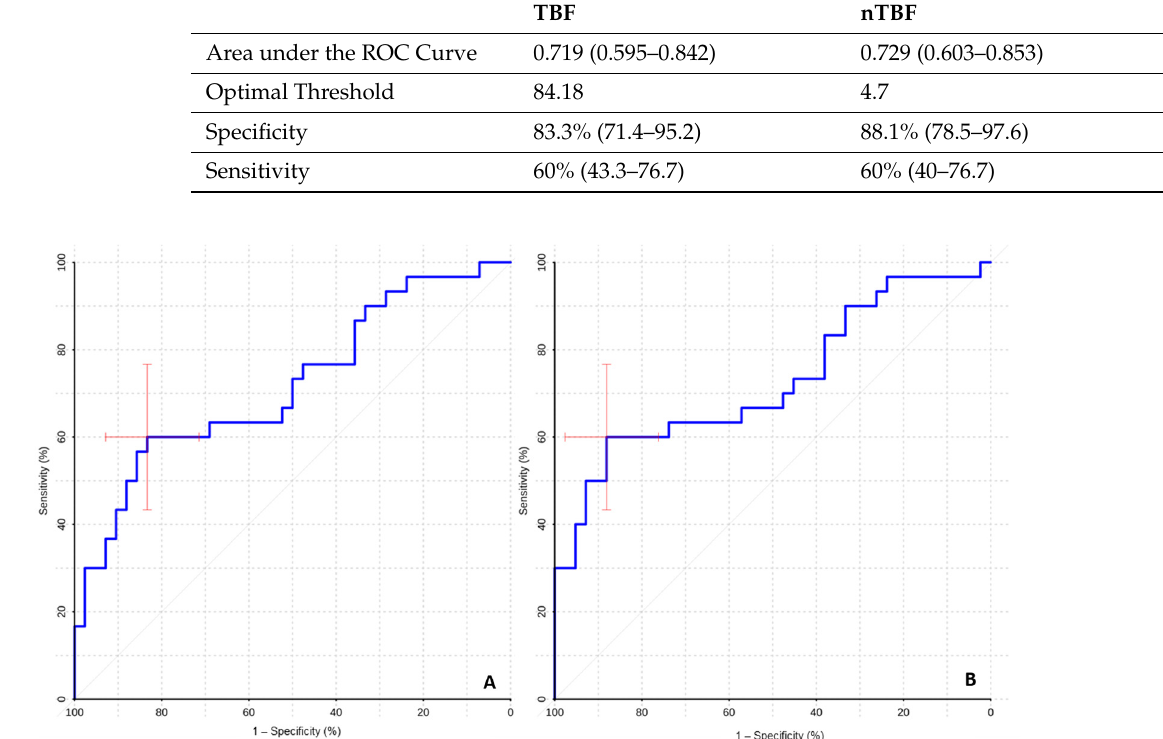
Figure 5. ROC curves. Comparison of maximum blood flow ( A ) and maximum normalized blood flow ( B ) between groups of malignant wildtype and IDH1-mutant gliomas.